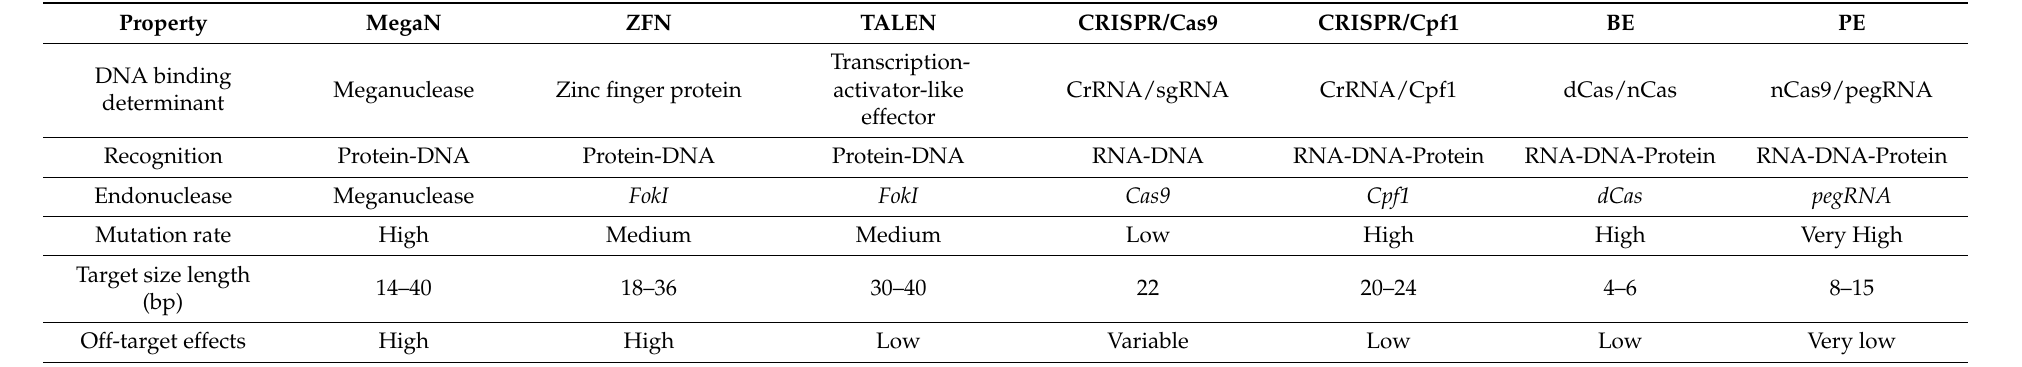
Table 1. Comparison of MegaN, ZFN, TALEN, CRISPR/Cas9, Cpf1, base editing, and prime